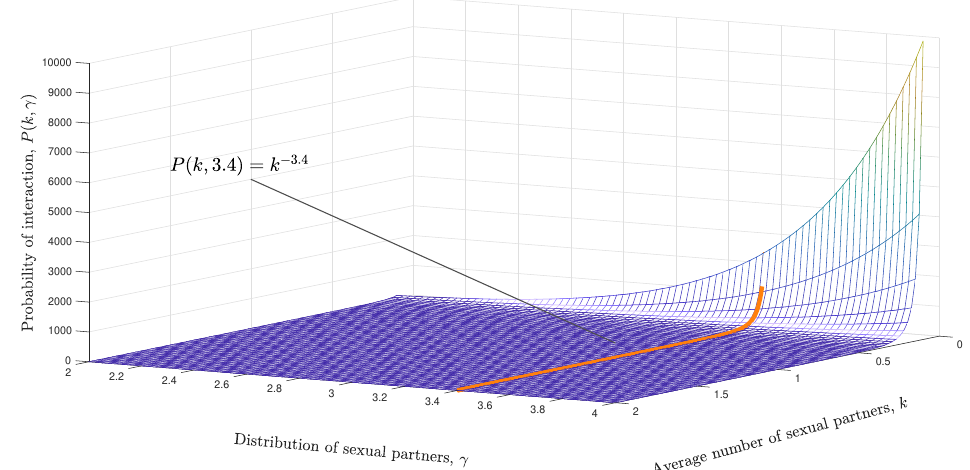
Figure 1. Graphic of P in space ( k , γ , P ) , for k ∈ [ 0,2 ] and γ ∈ [ 2,4 ] . The orange curve represents the fixed value γ = 3.4 used in the simulations in this